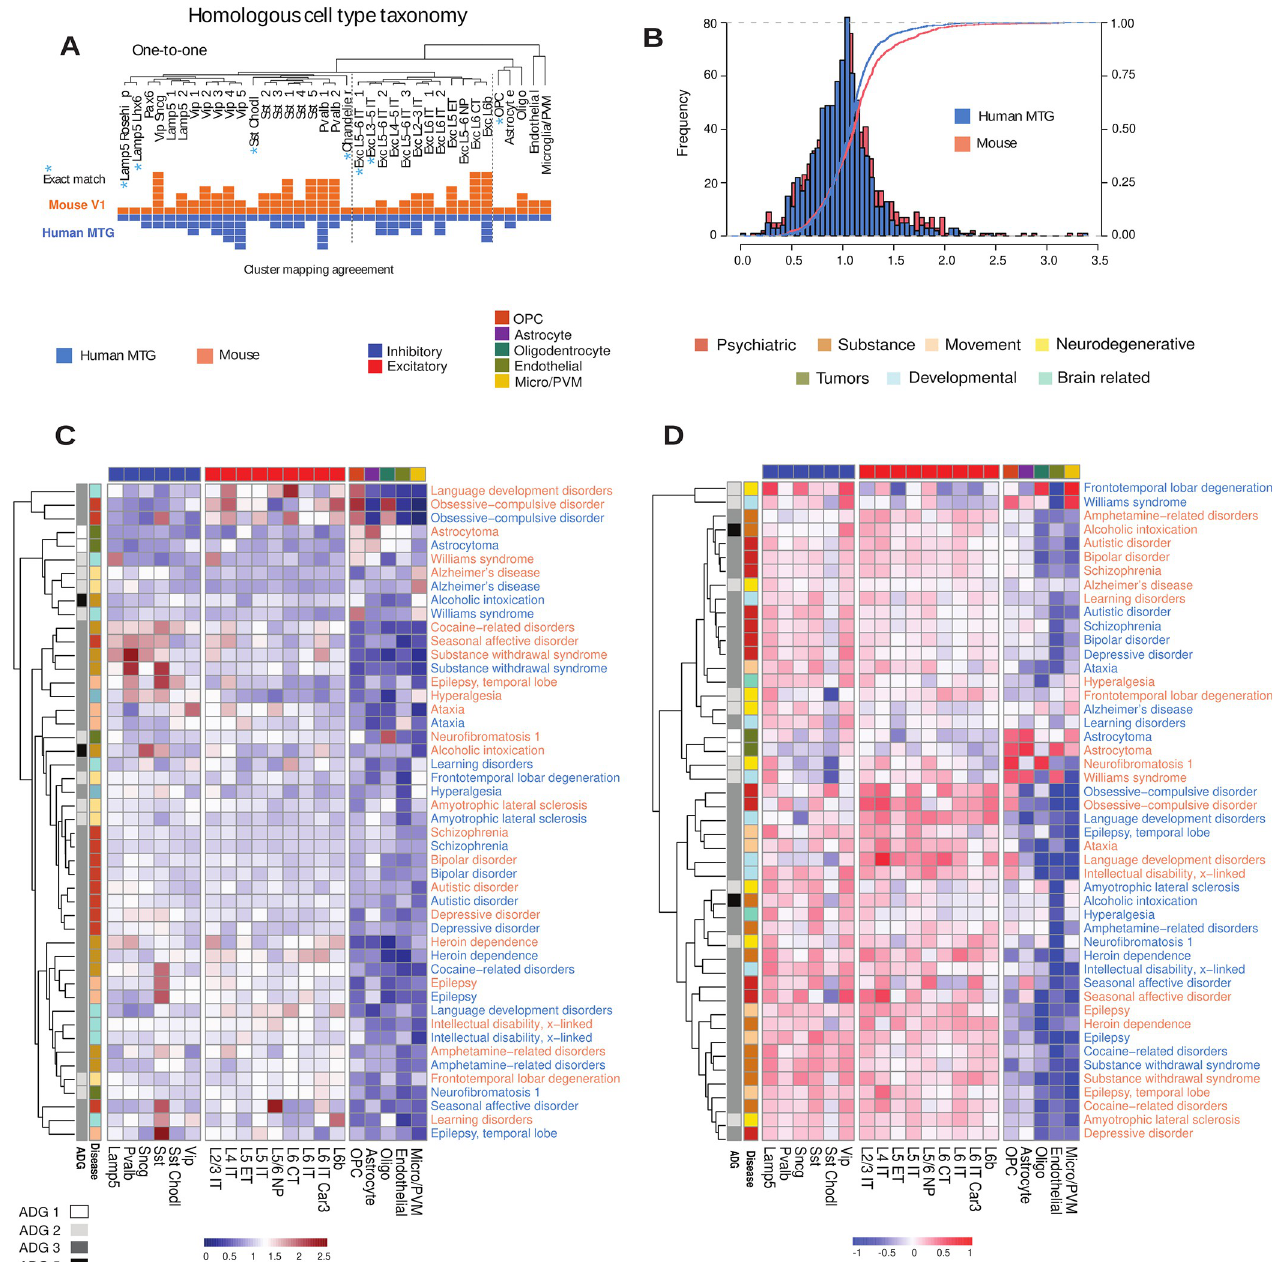
Fig 5. Disease-based cell type expression in mouse and human. (A) Alignment of transcriptomic cell types obtained in [15] of human MTG to 2 distinct mouse cortical areas, primary visual cortex (V1) and a premotor area, the ALM cortex, each square represents a mouse (orange) or human (blue) cell type cluster mapped to the homologous consensus cell type. (B) Histogram of mouse and human EWCE values [74] over subclass level of 20 aligned cell types. K-S goodness of fit test ( Methods ) shows that the distributions are marginally distinct (D = 0.091, p = 0.035). (C) Simultaneous clustering of mouse and human using EWCE disease signatures at subclass level 6 inhibitory, 9 excitatory, 5 non-neuronal (orange: mouse, blue: human) shows similarity of most diseases between species. (D) Similar clustering of mouse and human using average expression levels shows species-specific expression profiles while retaining GBD disease associations. Annotation top major cell classes, side disease GBD phenotype and ADG membership. Underlying data for Fig 5 can be found in S1 Table and the data from S1 Data (using EWCE_subclass as well as Cell_subclass expression files). Raw data available at https://portal.brain-map.org/atlases-and-data/ rnaseq under MTG SMART-seq (2018). Code for EWCE available through https://github.com/NathanSkene/EWCE. Code available as a notebook at https:// github.com/yasharz/human-brain-disease-transcriptomics. ALM, anterior lateral motor; EWCE, expression-weighted cell type enrichment; GBD, Global Burden of Disease; MTG, middle temporal